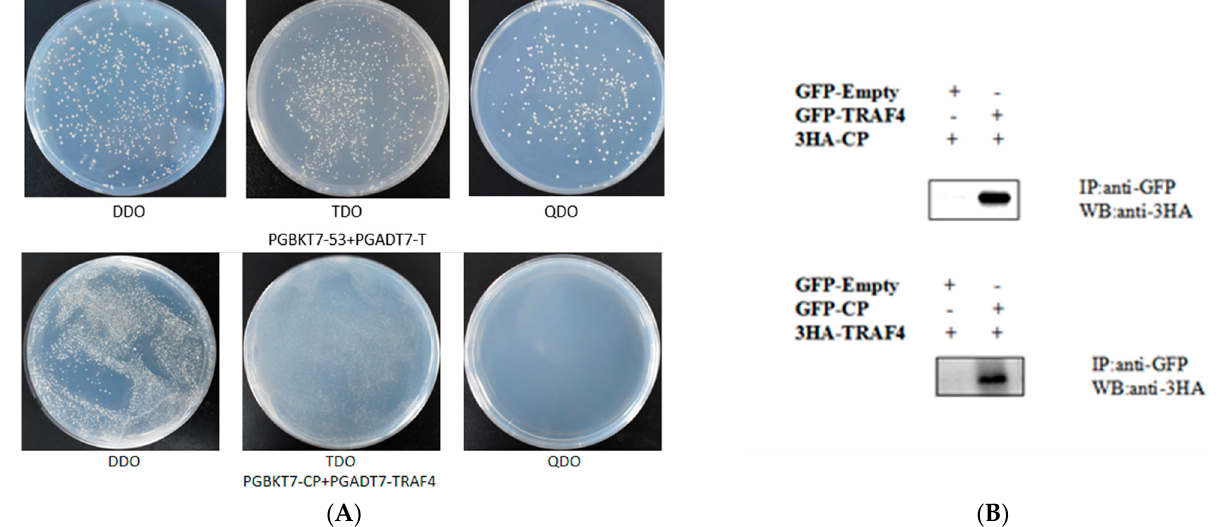
Figure 7. Interaction of CP with EcTRAF4. ( A ) For yeast two-hybrid analysis, pGBKT7-CP and pGADT7-EcTRAF4 plasmids were constructed for interaction verification. The two plasmids were co-transformed into S. cerevisiae strain Y2H Gold. The transformants were tested on a non-selective medium plate SD/-leu/-trp (DDO/X) to check whether the transformation was successful and the selective medium plate SD/-leu/-trp/-his/-ade/X- α -gal/AbA (QXA) to detect whether there was interaction between two proteins. ( B ) Co-immunoprecipitation resulted in GS cells showing that EcTRAF4 might interact with CP.